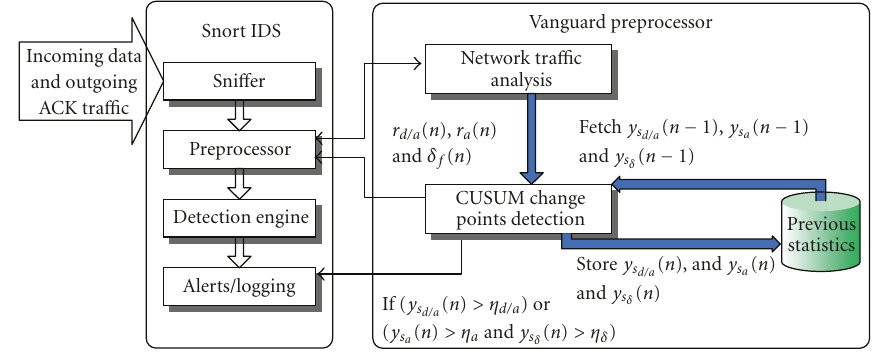
Figure 2: A Snort implementation of